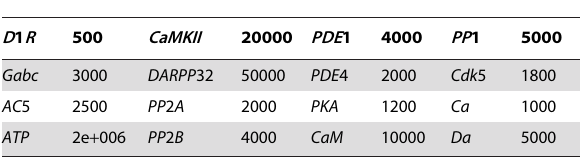
Table 4. Initial